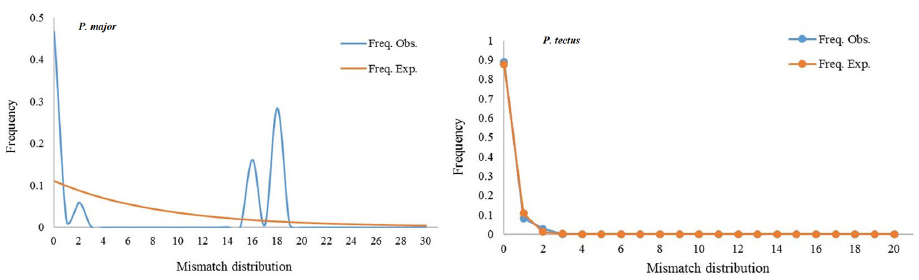
Figure 5. Mismatch distribution analysis of P. major and P. tectus from 23 locations based on COI gene.